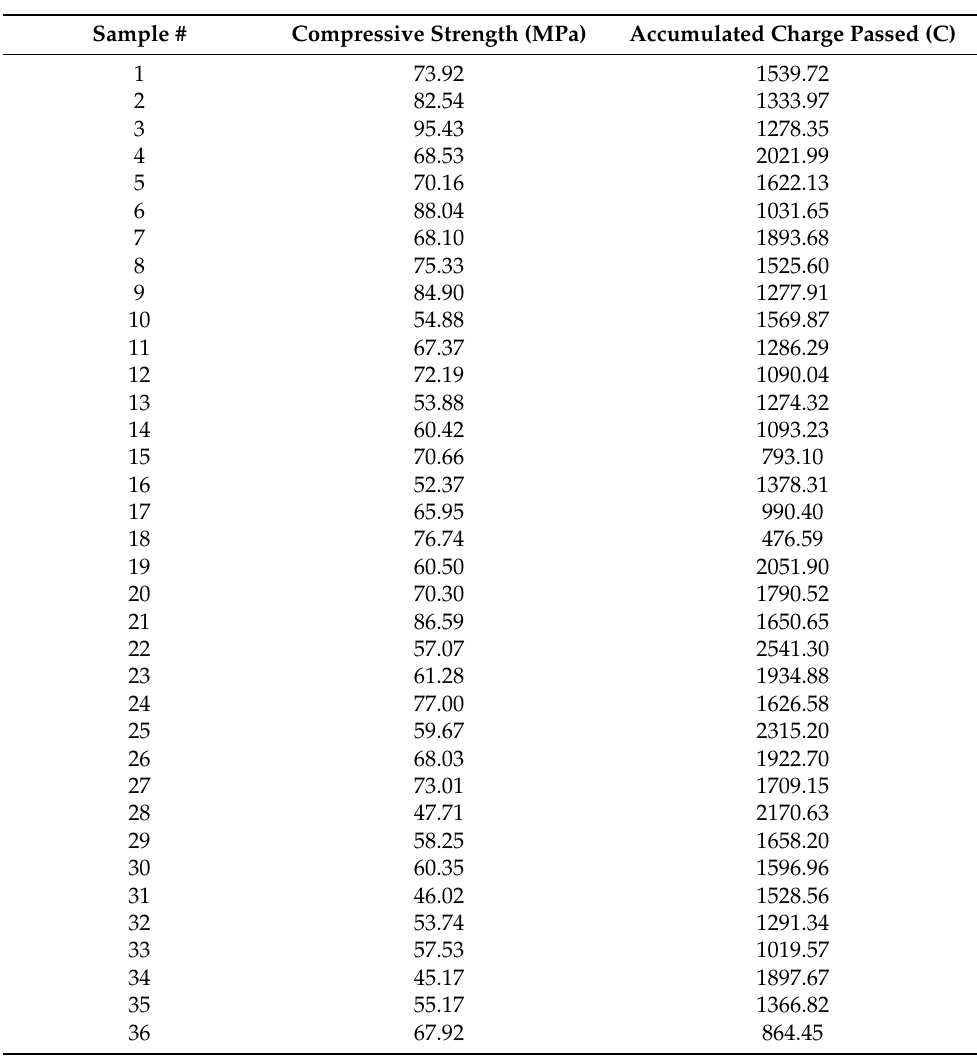
Table A6. Data table for data analysis and